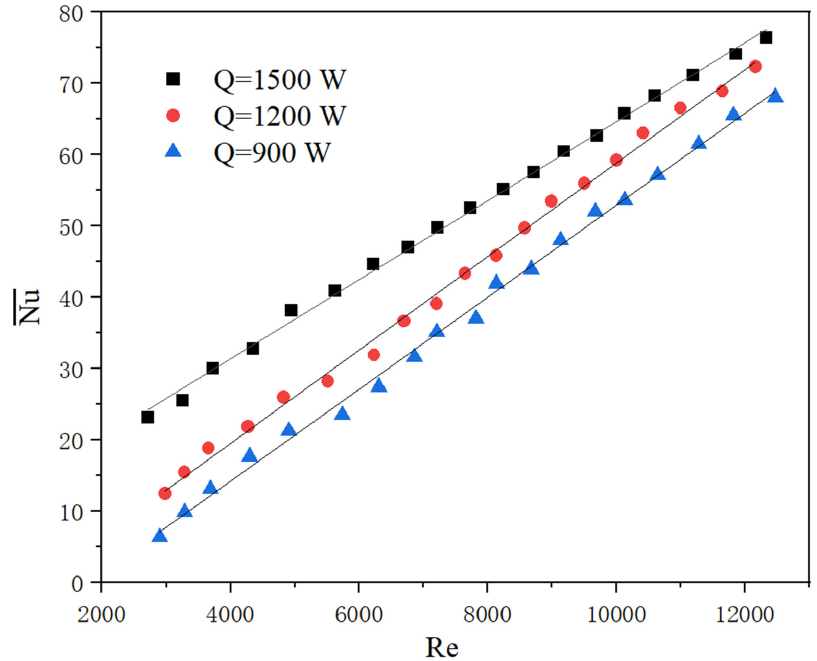
Figure 13. Nu variation with Re at different heating powers.